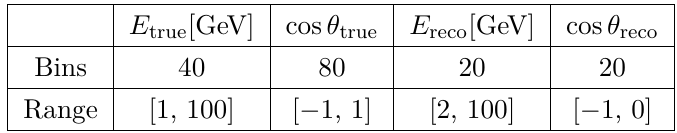
Table 1. Bin choice for the MC-based response matrix used in this analysis. Energy bins are equally spaced in log . 10